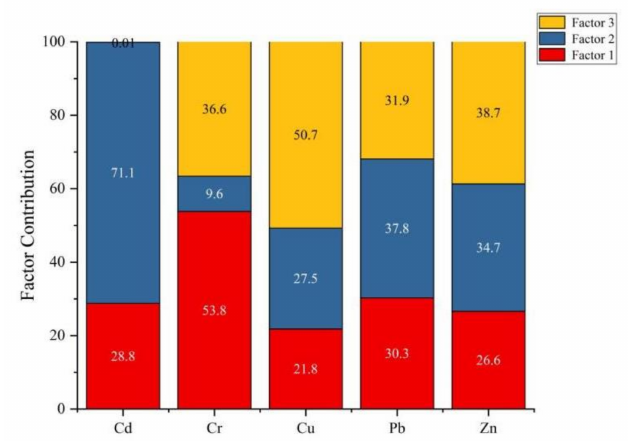
Figure 7. Analytical contribution of heavy metal PMF